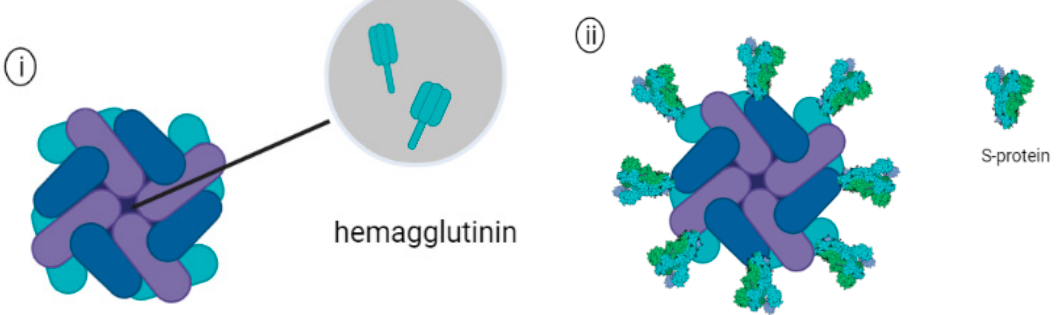
Figure 7. Schematic representation of ( i ) Ferritin encapsulating trimeric hemagglutinin (HA) and ( ii ) Ferritin attached with Sars-Cov-2 spike proteins.